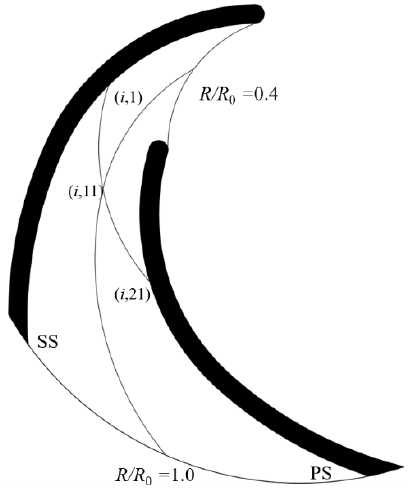
Figure 16. Schematic diagram of meridian distribution.